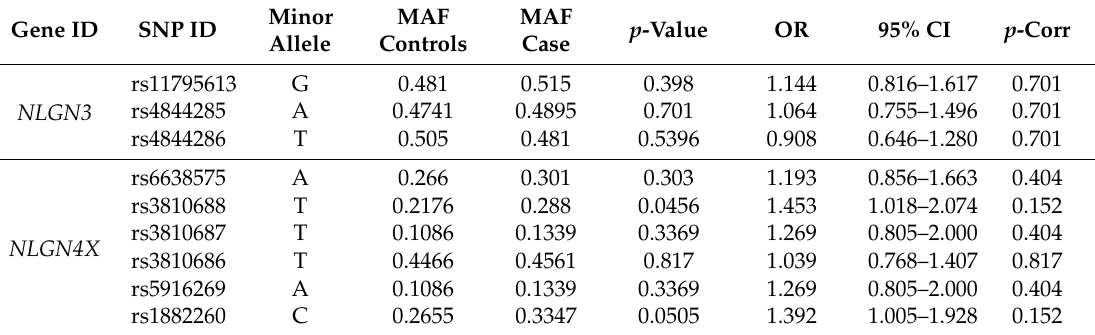
Table 1. Single locus analysis for all the single nucleotide polymorphisms (SNPs) genotyped in NLGN3 and NLGN4X (EUR control